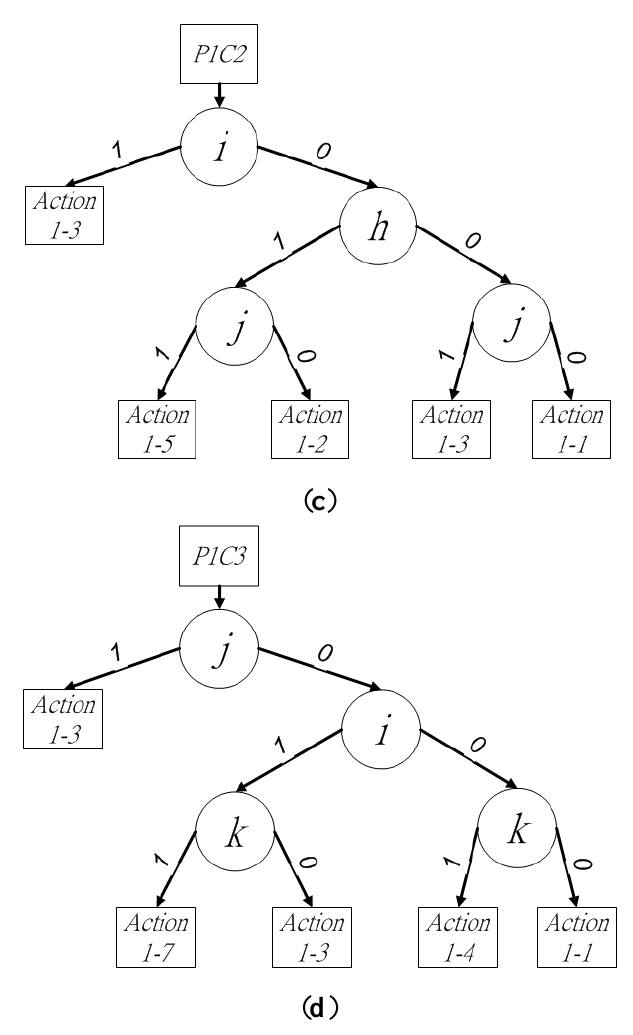
Figure 4. Binary decision tree of ( a ) procedure 1, ( b ) P1C1 , ( c ) P1C2 and ( d )